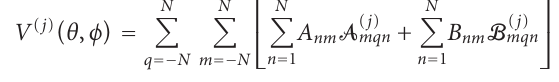
Figure 2: The higher-order test probe with its reference point at ( θ 0 , φ 0 ) on the scan sphere of radius R . The output of Port no. 1 is V (1) ( θ 0 , φ 0 ) = E θ ( R , θ 0 + ψ , φ 0 ), and the output of Port no. 2 is V (2) ( θ 0 , φ 0 ) given by